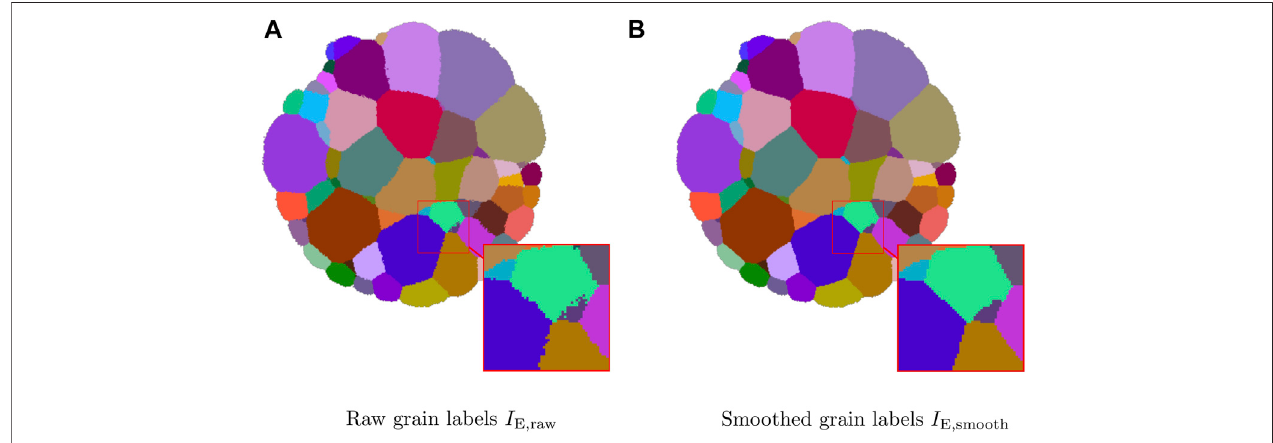
FIGURE 1 | Two-dimensional slice through the raw (A) and smoothed (B) experimental 3D image data and a magni fi ed region showing the grain boundaries.